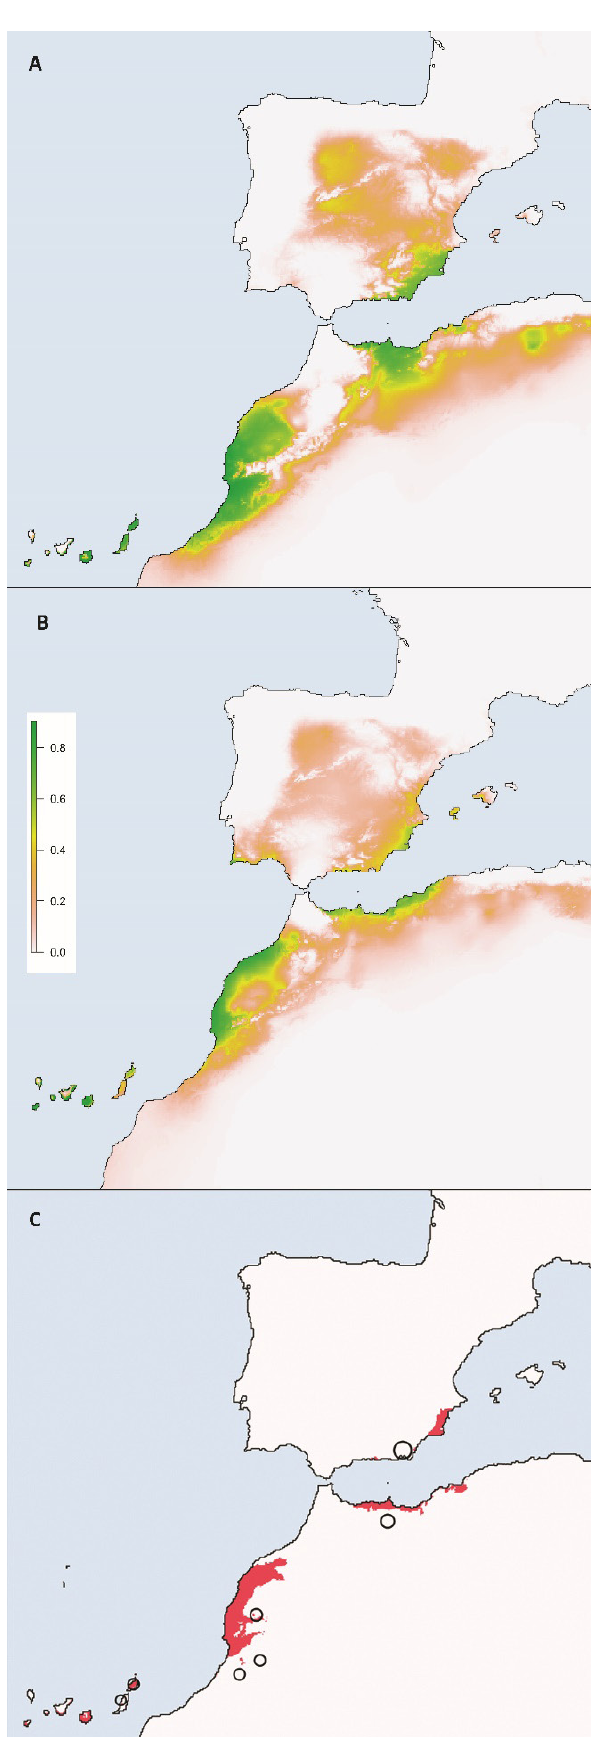
Figure 3. A, Distribution model representing the habitat suitability for the species in the present (red-yellow, medium, green, high; Bobo-Pinilla et al. , 2018); B, Projected habitat suitability values for the species in the future scenario 2070_RCP8.5 (red-yellow, medium, green, high); C, red areas represent suitable areas for the species in the present and future scenarios, circle represent present populations. (slightly modified from Bobo-Pinilla et al .,